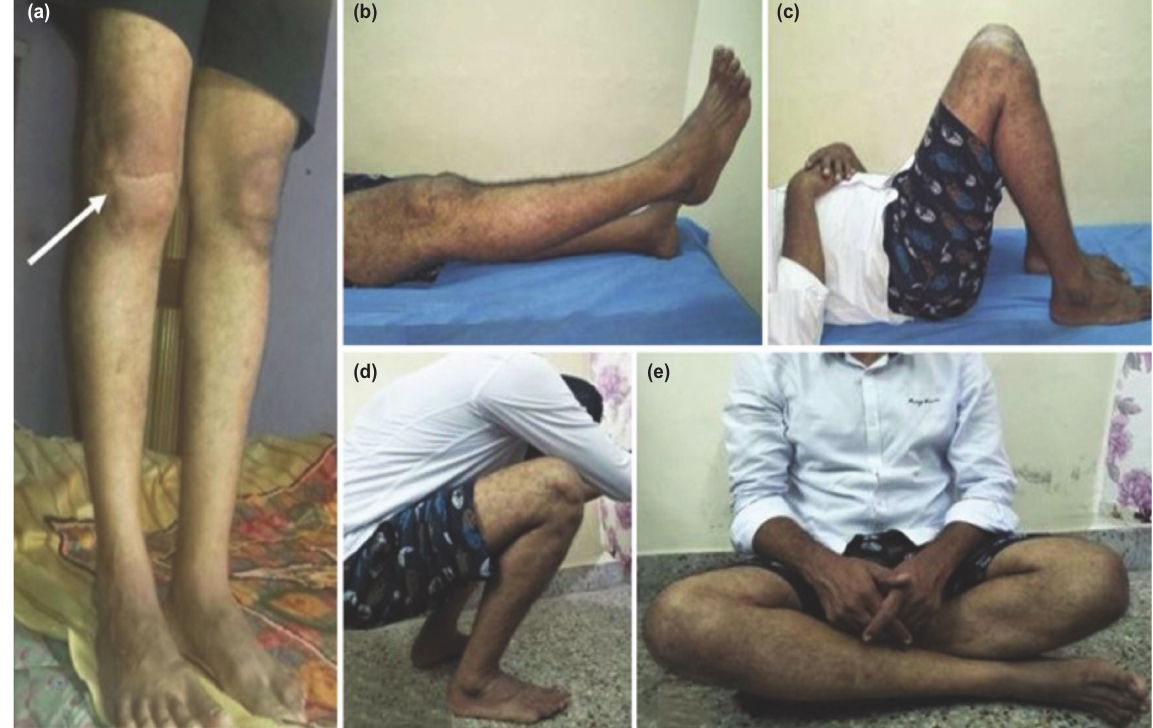
At final clinical follow-up of 15 years showing the patient, (a) standing with both knees in alignment (white arrow pointing to Fig. 3: the right knee with a healed transverse laceration), (b) actively extending his right knee till 0° with no lag, (c) with right knee flexion of 130°, (d) squatting and (e) sitting